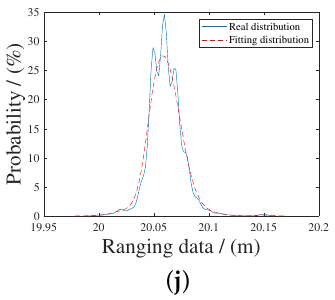
Figure 5. The probability of ranging measurements is shown, when distances are ( a ) 0.7 m, ( b ) 1 m, ( c ) 1.5 m, ( d ) 2 m, ( e ) 3 m, ( f ) 5 m, ( g ) 7 m, ( h ) 10 m, ( i ) 15 m, ( j ) 20 m. At every experiment, the probability distribution is approximately Gaussian distribution, but there is a deviation between the maximum probability value and the true value, shown in Table 1.